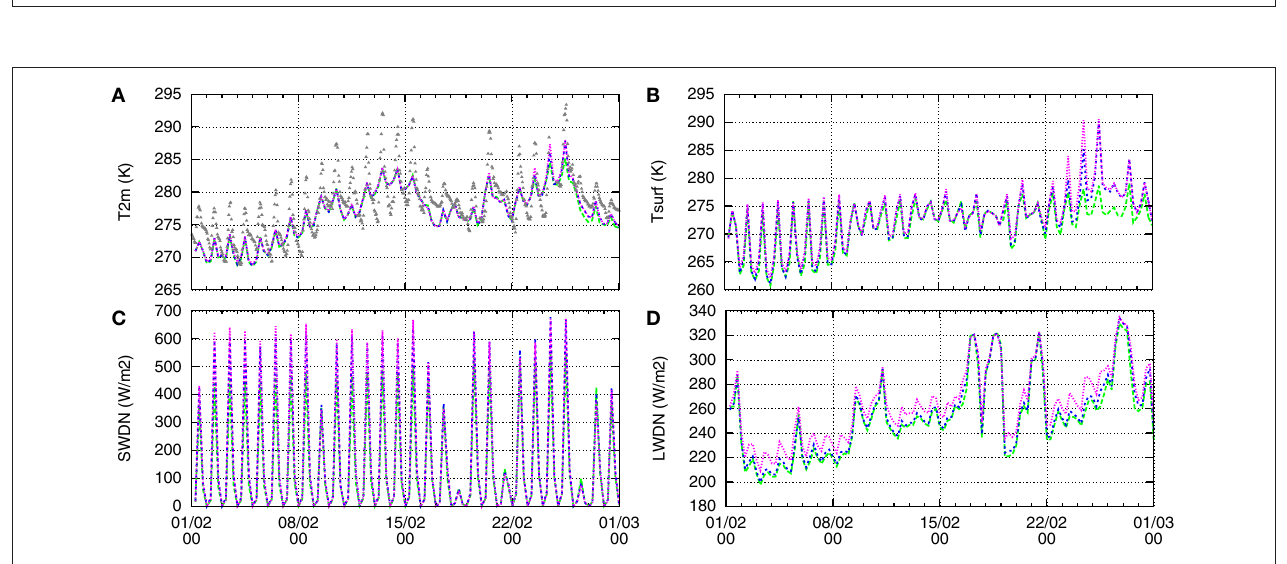
FIGURE 10 | (A) Predicted (lines) and hourly observed (gray triangles) T 2 m and (B) T s (temperature units: K); (C) 6-h average global SWD and (D) 6-h average LWD radiation flux (radiation flux units: Wm − 2 ), picked from + 6 h forecasts by harcau0 (green), harcau3 (blue), and harcau6 (magenta) starting at 00, 06, 12, and 18 UTC in February 2014 at Olympic valley station Krasnaya Polyana (37107, Table 3 ).